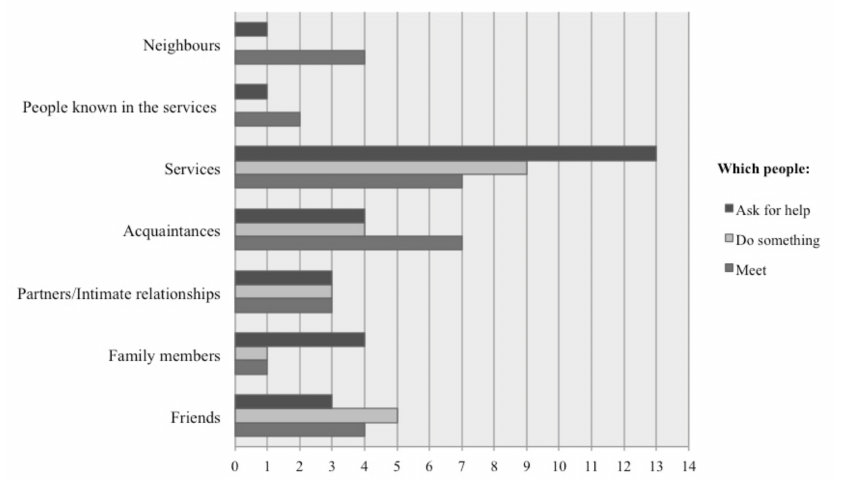
Figure 1. Frequency of responses to the question: ‘With whom do you meet/do something/get